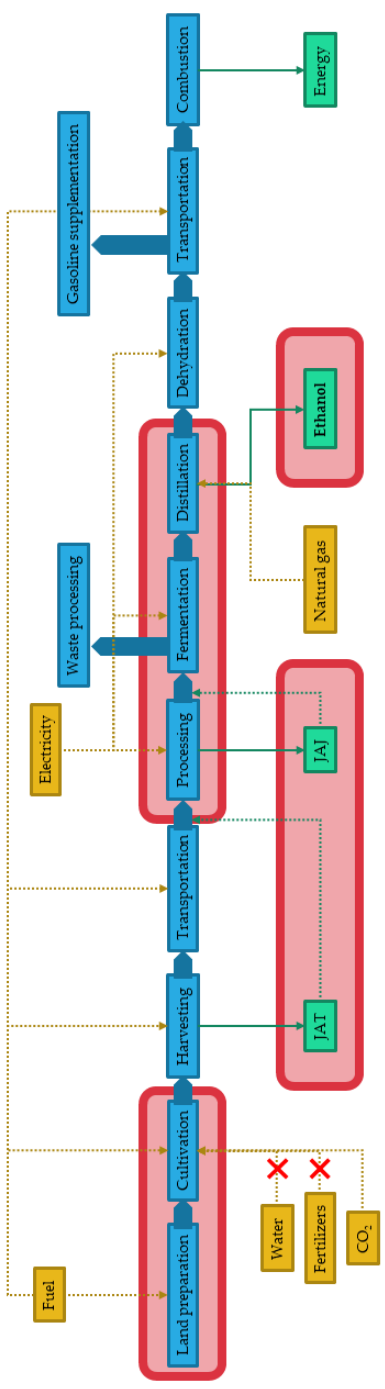
Figure 1. Process chain for the production of bioethanol from JA. Blue boxes: main processes; Yellow boxes: inputs; Green boxes: outputs. All processes were considered to emit CO 2 eq. System boundaries include the red highlighted processes and respective inputs and outputs. (JAT: JA tubers; JAJ: JA juice).